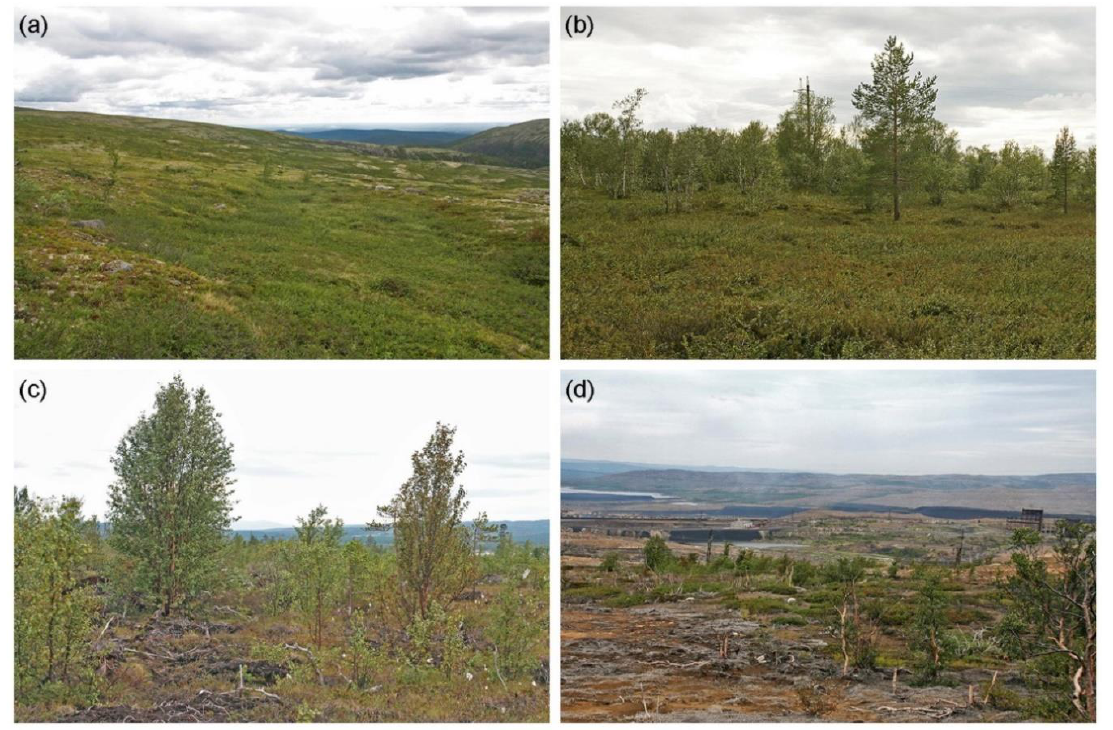
Figure 2. Landscape and the state of vegetation at the study sites: ( a ) site 45 E, unpolluted tundra; ( b ) site 38 S, unpolluted forest; ( c ) site 3 SW, severely damaged forest; ( d ) site 1.4 E, industrial barren.